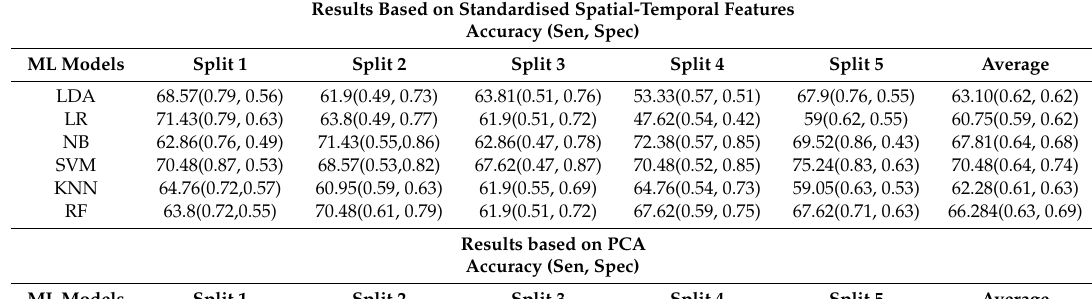
Table A1. ML model results for accuracy (sensitivity, specificity). Results Based on Standardised Spatial-Temporal Features Accuracy (Sen, Spec)